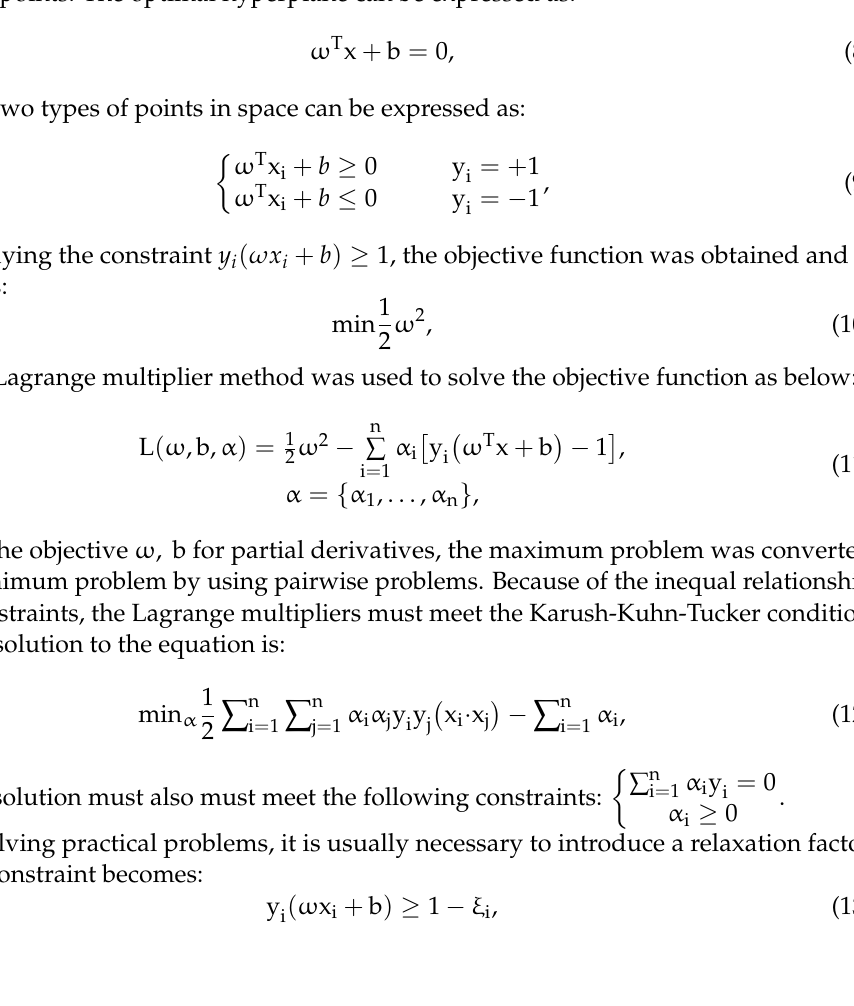
Figure 7. SMOTE echocardiogram dataset validated accurately.